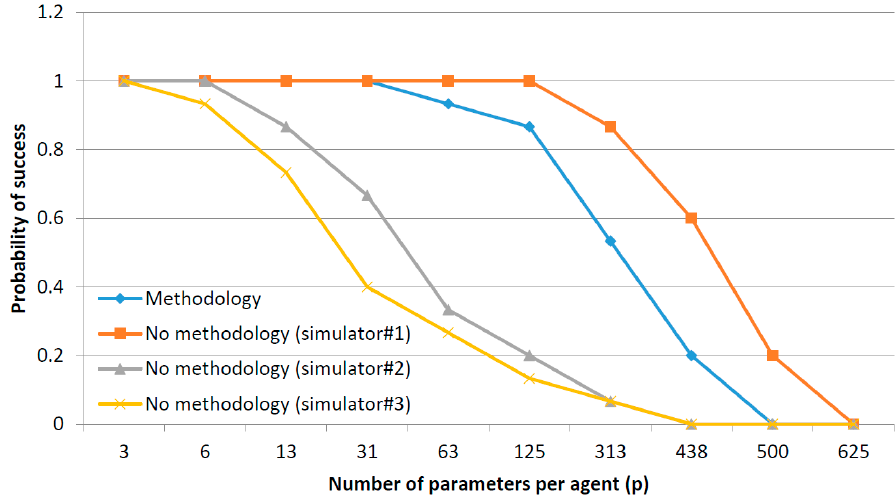
Figure 19. Scalability of the proposed co-simulators considering the number of parameters per agent.